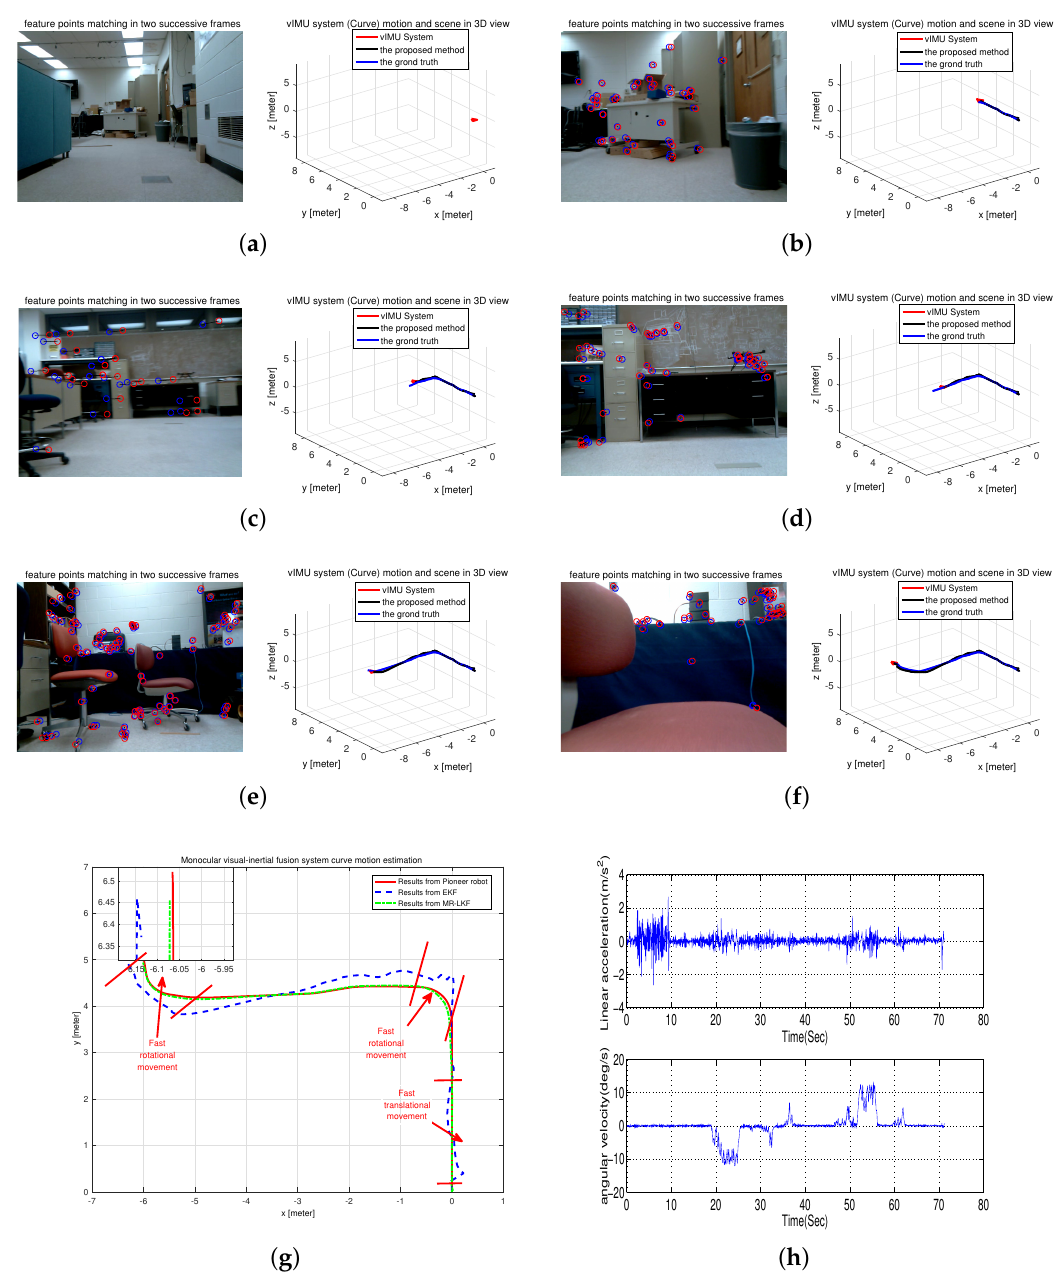
Figure 11. Curve Motion Estimation in an office room. ( a – f ) typical frames; ( g ) estimated trajectory with a magnified final position; ( h ) inertial